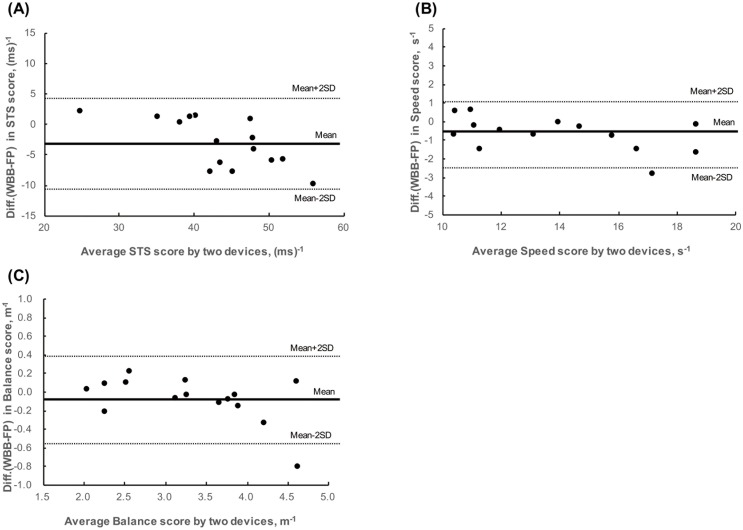
Bland–Altman plots representing comparisons between the laboratory-grade force plate (FP) and the Wii Balance Board (WBB) for STS score (A), speed score (B), and balance score (C).The mean line represents the mean difference between the devices, with the upper and lower lines representing the limits of agreement (two standard deviations).